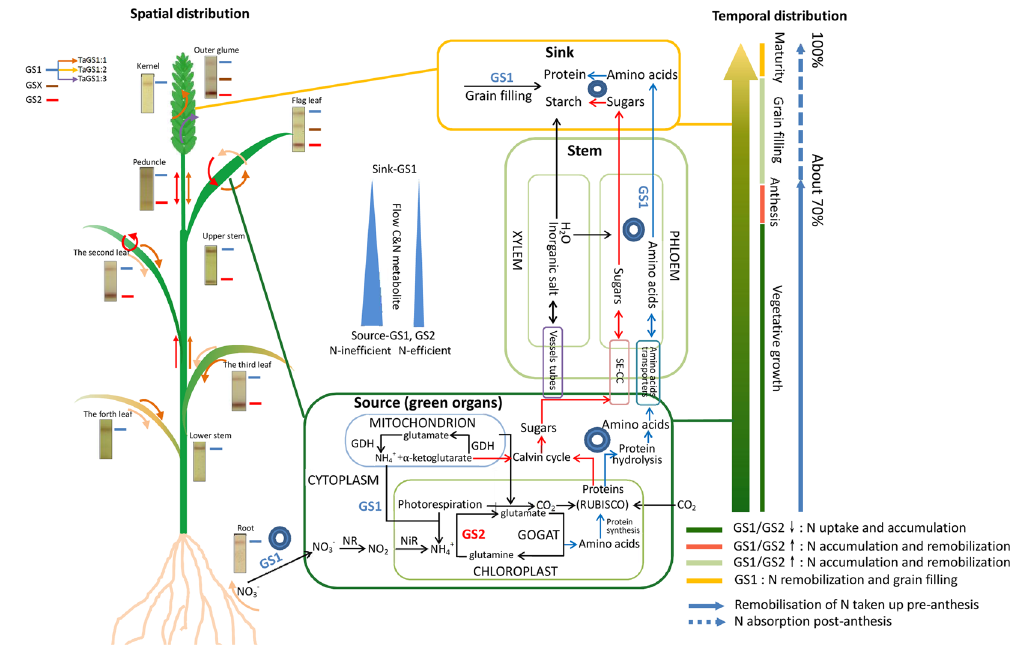
Figure 6. Schematic diagram of the spatial and temporal regulatory points of GS isozymes. Linear arrows indicate C and N fluxes. Blue arrows indicate amino acids fluxes. Red arrows indicate sugars fluxes. Concentric circles indicate the possible regulatory points through amino acid and sugar flow caused by pool strength in source-sink-flow